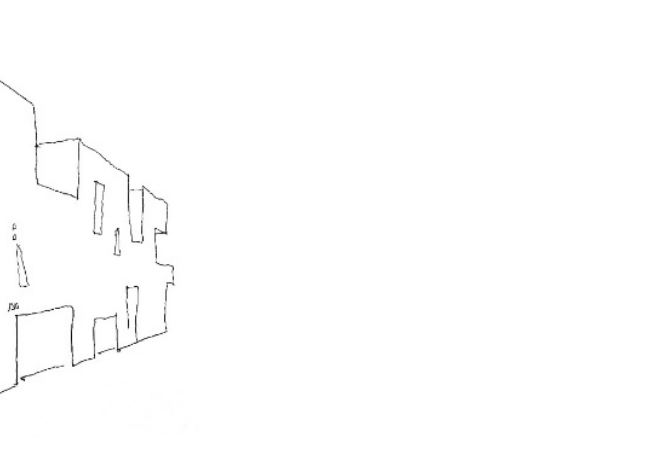
Figure 4. A perspective drawing of Steven Holl’s Simmons Hall at the MIT Campus in Cambridge, Massachusetts. A new epoch of fractal architecture has already started.